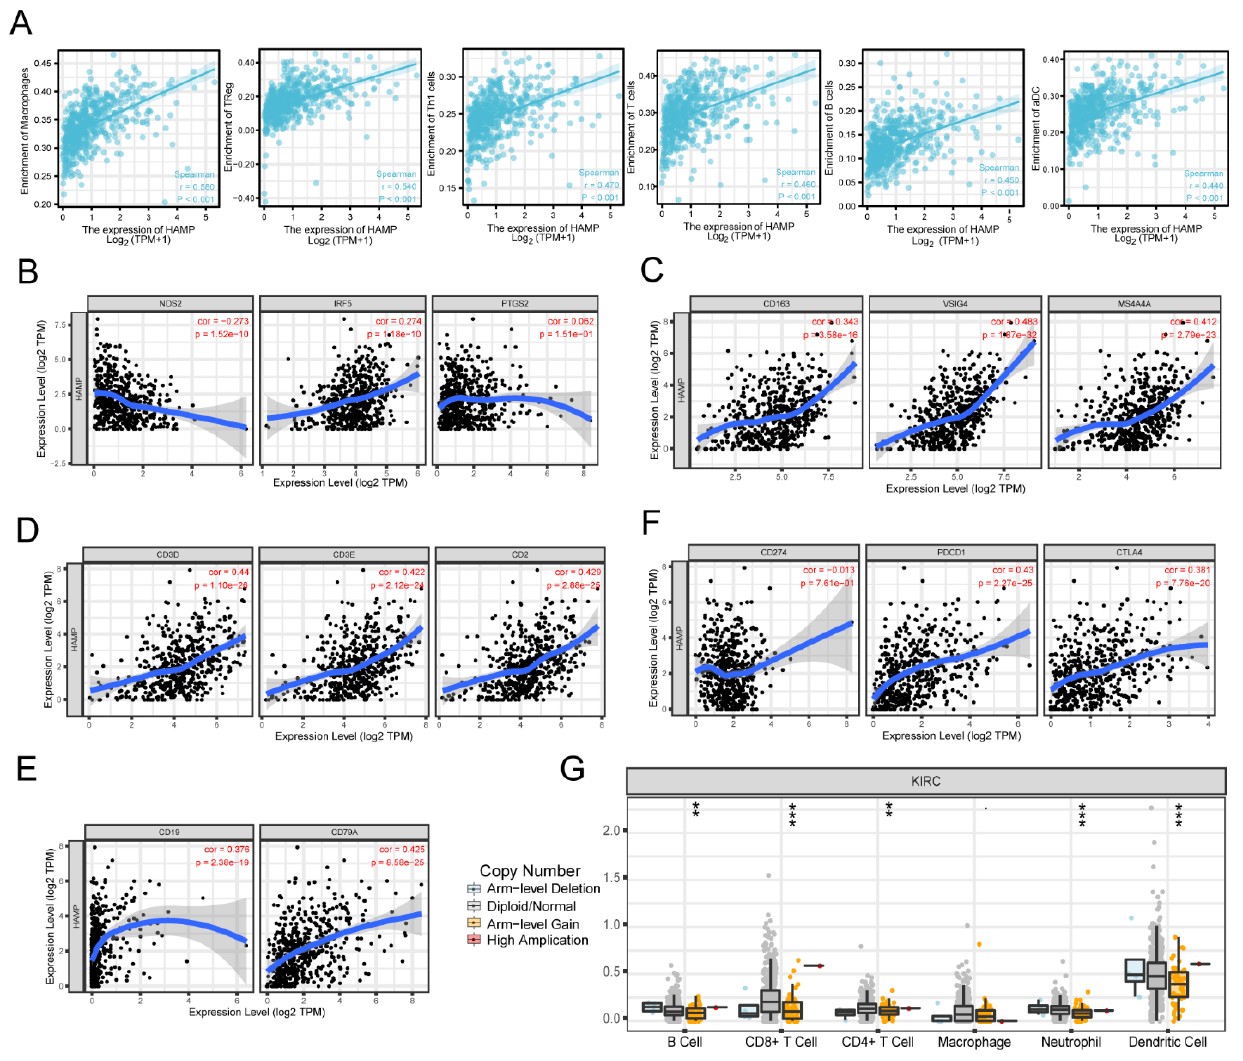
Figure 4. Correlation between expression levels of HAMP and immune infiltration levels in KIRC. ( A ) The enrichment in macrophages, Treg, Th1 cells, T cells, B cells and aDC based on the expression levels of HAMP in tumors. ( B − E ) Expression scatterplots between the expression levels of HAMP and the immune marker genes of M1/M2 macrophages, T cells and B cells in KIRC based on the TIMER database. ( F ) The immune checkpoint infiltration level versus the expression levels of HAMP in KIRC based on the TIMER database. ( G ) Significant differences in the somatic copy number alterations (SCNAs) in KIRC (** p < 0.01, *** p < 0.005). Table 2. Correlation analysis between HAMP and the related marker genes of monocytes and mac- rophages in GEPIA.